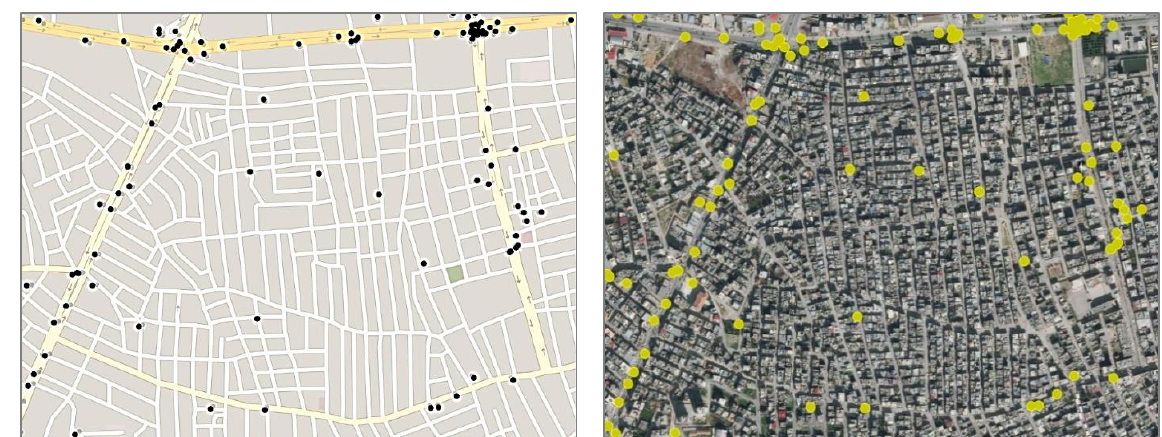
Figure 12 Street Network and Location of Accidents in Güneş